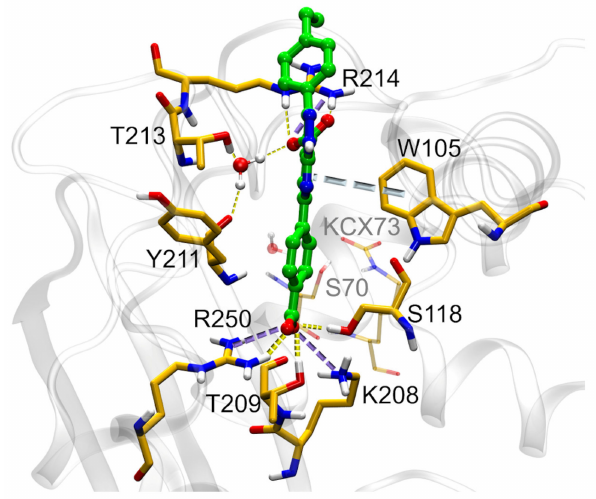
Figure 14. X-ray cocrystal structure of ID2 in complex with OXA-48 enzyme (PDB code 7AUX). The ligand and the most relevant residues of the binding pocket are reported in green and yellow, respectively. Hydrogen bonds, electrostatic and π – π interactions are represented as yellow, purple, and grey dashed lines. For the sake of clarity, some portions of the protein have been